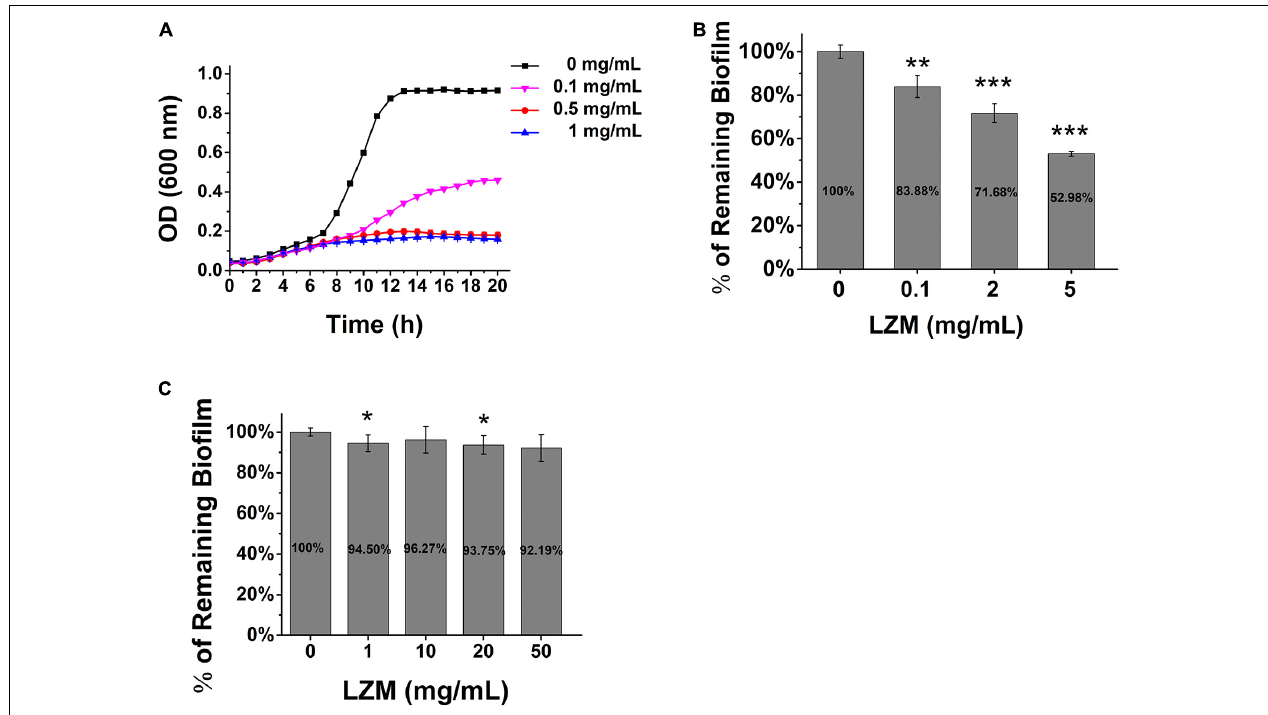
FIGURE 2 | Lysozyme inhibits S. mutans growth and biofilm formation. (A) The growth of S. mutans in BHI broth in various concentrations of lysozyme. (B) The quantification of biofilm formation in various concentrations of lysozyme. (C) Pre-formed biofilm treated with various concentrations of lysozyme. Statistical significance is indicated as compared with untreated biofilms using a t -test. All of the values shown represent the mean ± standard deviation of the results from three independent experiments. * p < 0.05; ** p < 0.01; *** p <